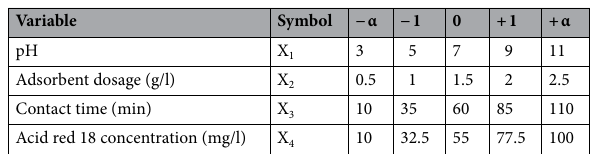
Table 2. Independent variables and the levels of each